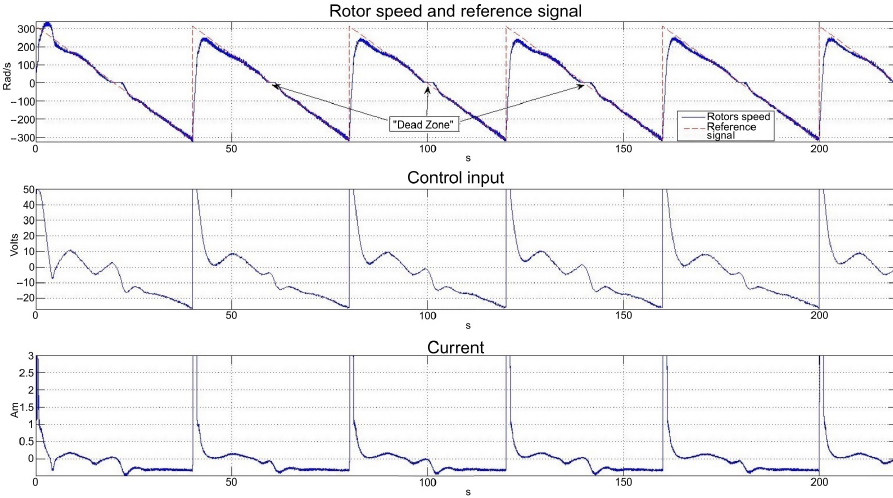
Figure 24. Responses to a “Sawtooth” reference.